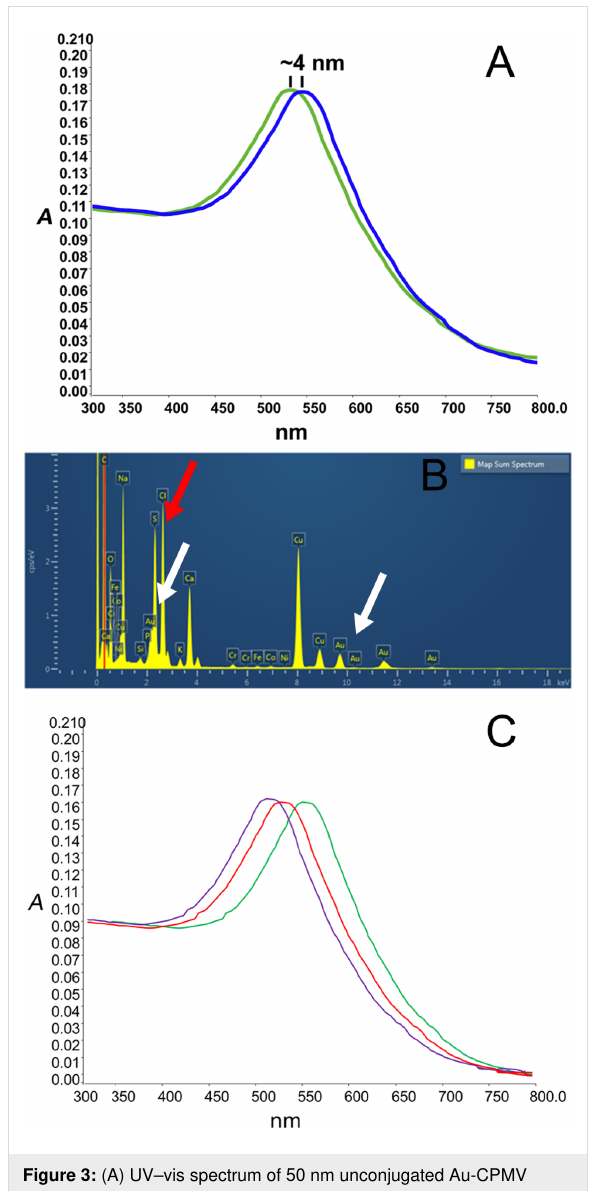
Figure 3: (A) UV–vis spectrum of 50 nm unconjugated Au-CPMV (green) and antibody-labeled Au-CPMV particles (blue). The spectrum shows a red-shift of 4 nm, while preserving the overall shape and in- tensity of the spectrum, confirming successful coupling of the antibody to the Au-CPMV surface. (B) EDX analysis confirms the presence of gold (white arrows) and sulfur (red arrow), Si and Cr signals are from the sample holder. (C) UV–vis spectrum of the SPR bands of Au-CPMV; λ max = 535 nm for particles with a diameter of 50 nm (purple line), λ max = 552 nm for particles with a diameter of 70 nm (red line) and λ max = 572 nm for particles with a diameter of 100 nm (green